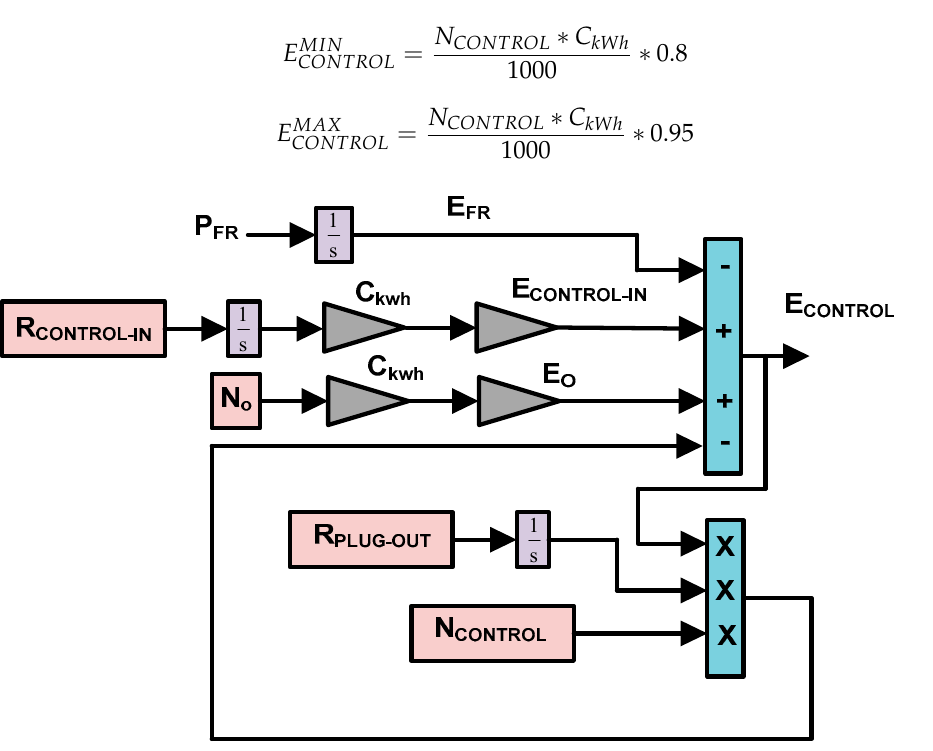
Figure 2. The total energy model (TEM) of an EV.